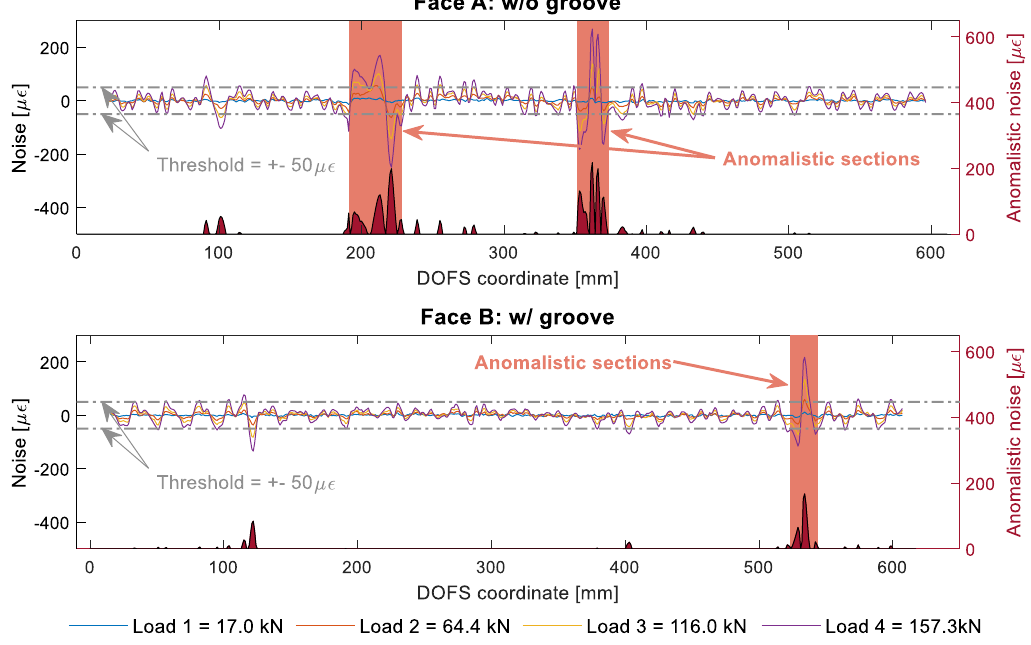
Figure 19. Member 15D20_24_2 Face A’s ( top ) and B’s ( bottom ) noise level study for SRA analysis.